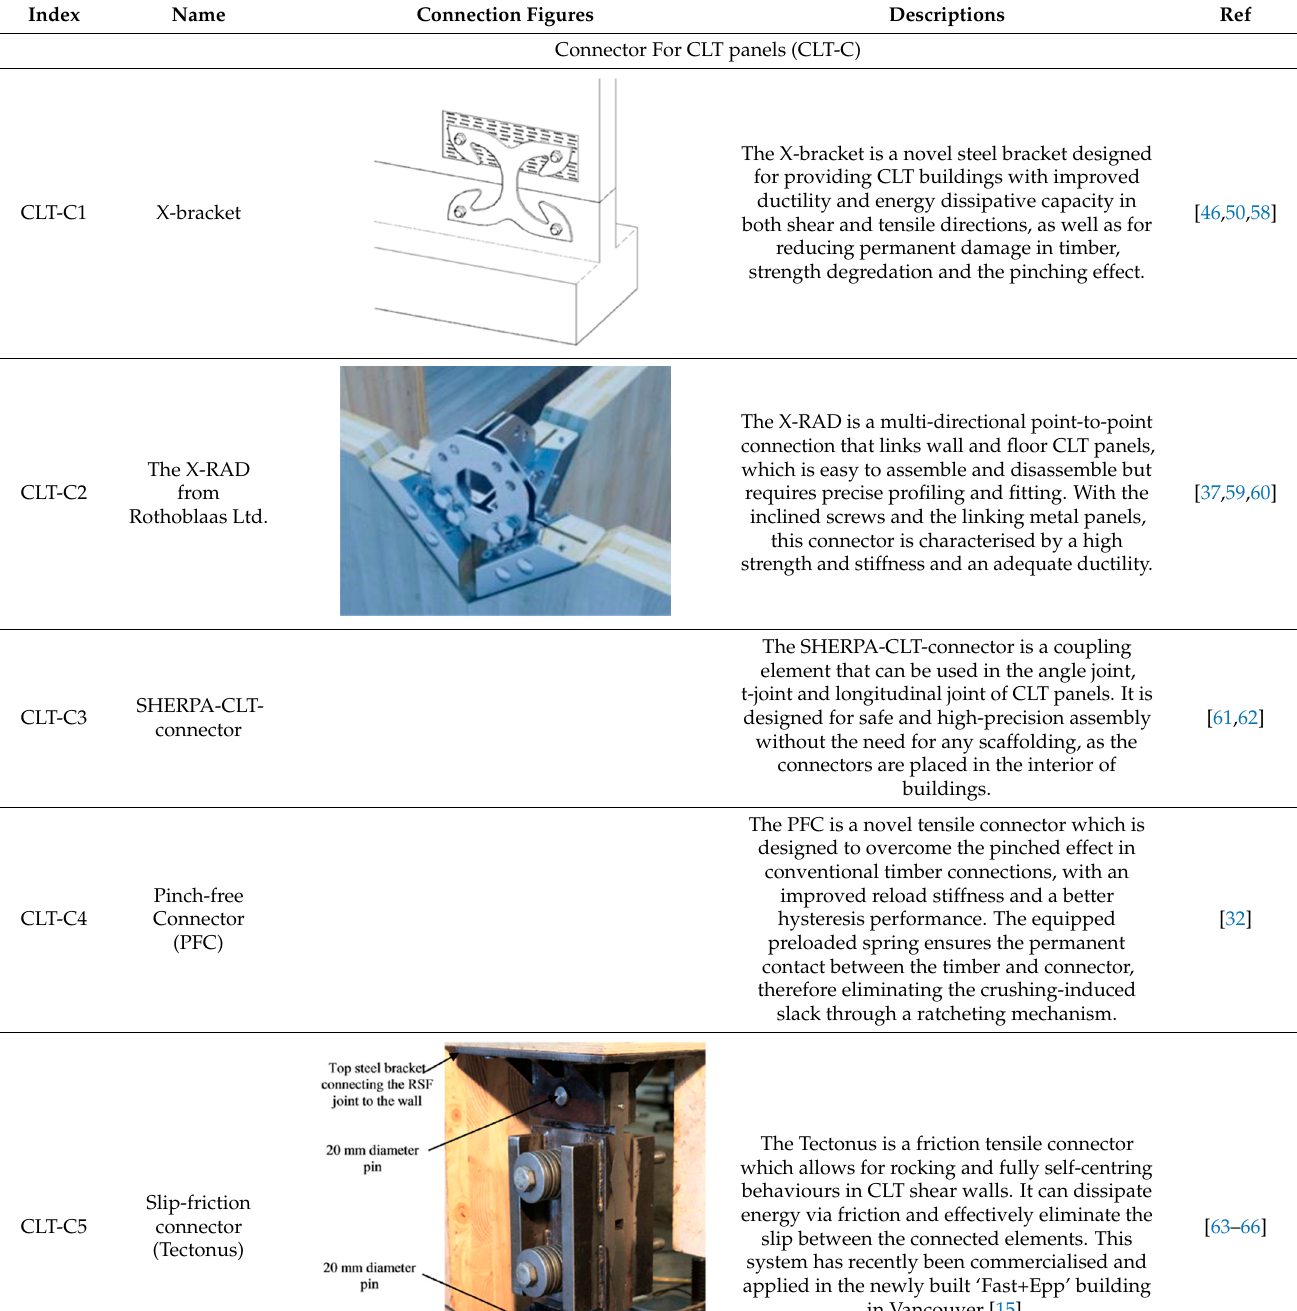
Table 1. Innovative connectors for CLT shear wall systems.